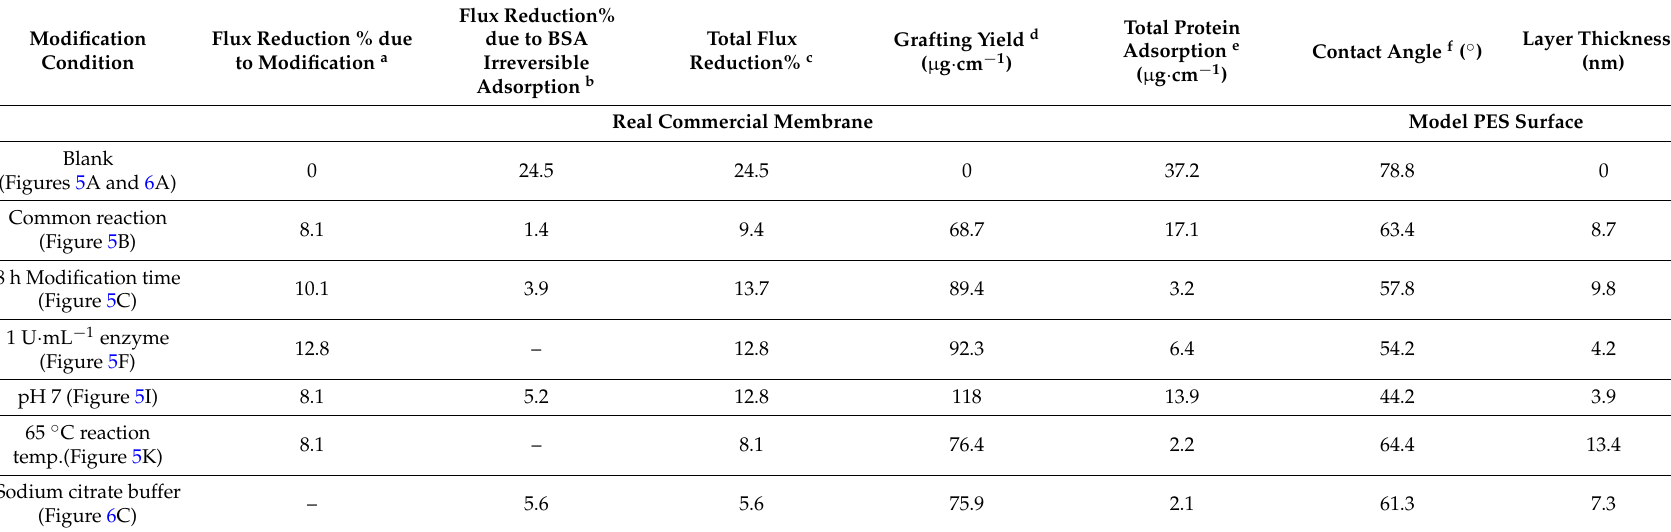
Table 2. Flux reduction (% compared to blank) due to modification and (irreversible) protein adsorption under different modification conditions. Contact angle, layer thickness (model membrane), grafting yield, and total protein adsorption (reversible + irreversible) of some tested membranes in this study. Common